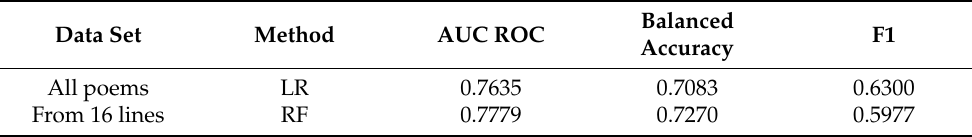
Table 5. Results of classifications by punctuation marks for the main data set.